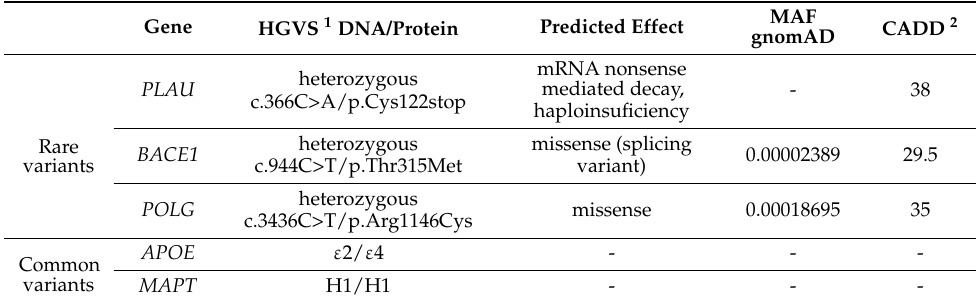
Table 1. The highest impact variants detected in the patient. Gene HGVS 1 DNA/Protein Predicted